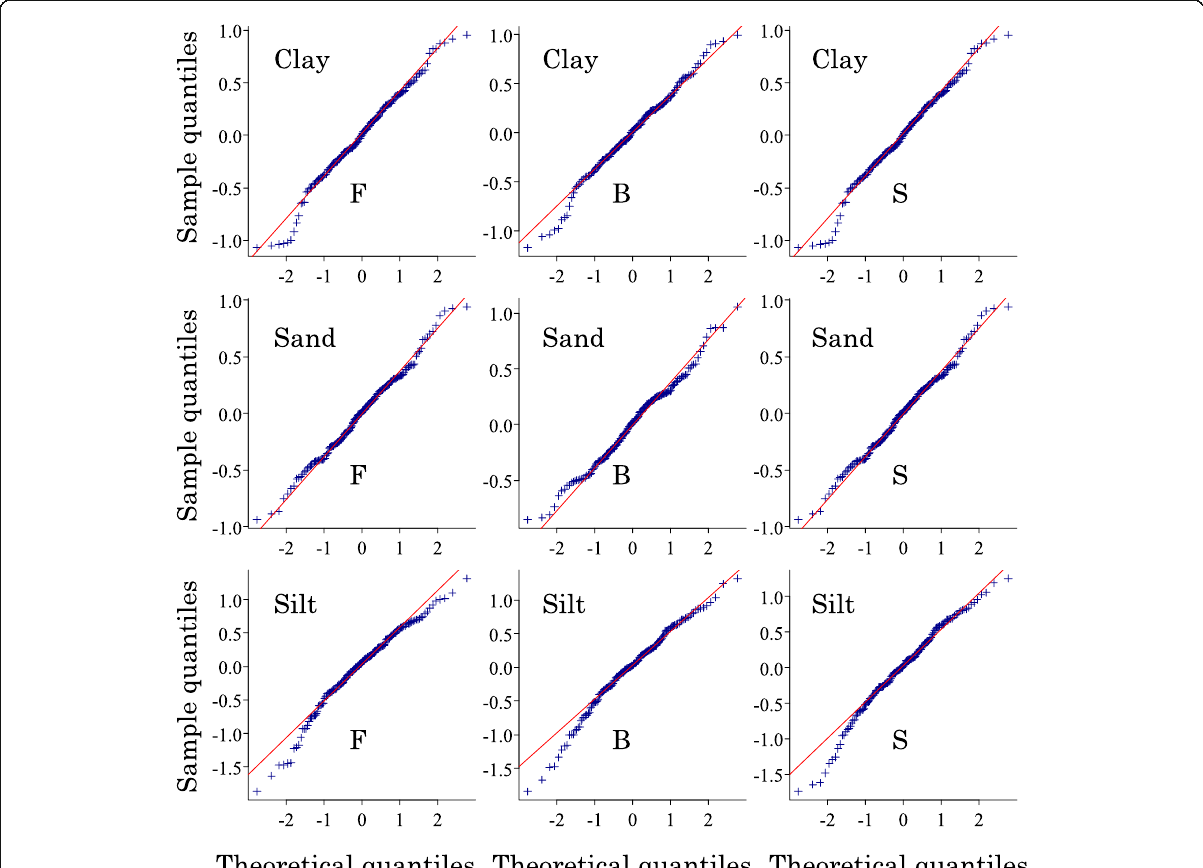
Fig. 3 QQ plots of residuals of the multiple linear regression models applying forward (F) selection, backward (B) elimination, and stepwise (S) selection